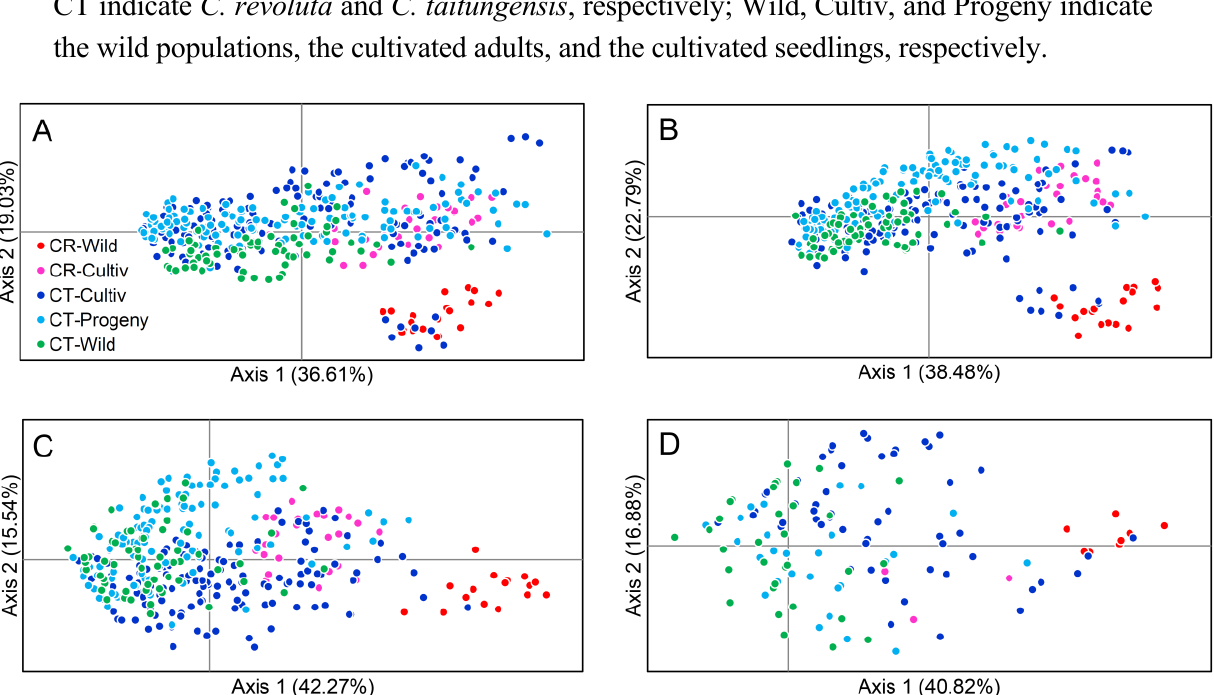
Figure 2. The first two axes plots of principle coordinate analysis (PCoA) calculated using ( A ) 262 neutral loci; ( B ) 91 species-associated loci determined under criteria LOD 3.0; ( C ) 23 species-associated loci determined under criteria LOD 6.0; and ( D ) 10 species-associated loci of the linkage subgroup 1 under criteria LOD 6.0. Abbreviations CR ad CT indicate C. revoluta and C. taitungensis , respectively; Wild, Cultiv, and Progeny